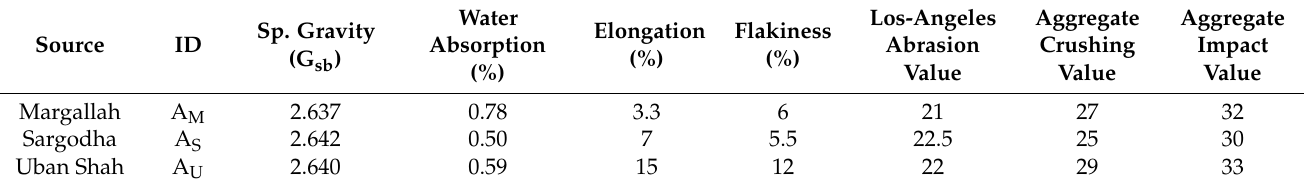
Table 1. Properties of